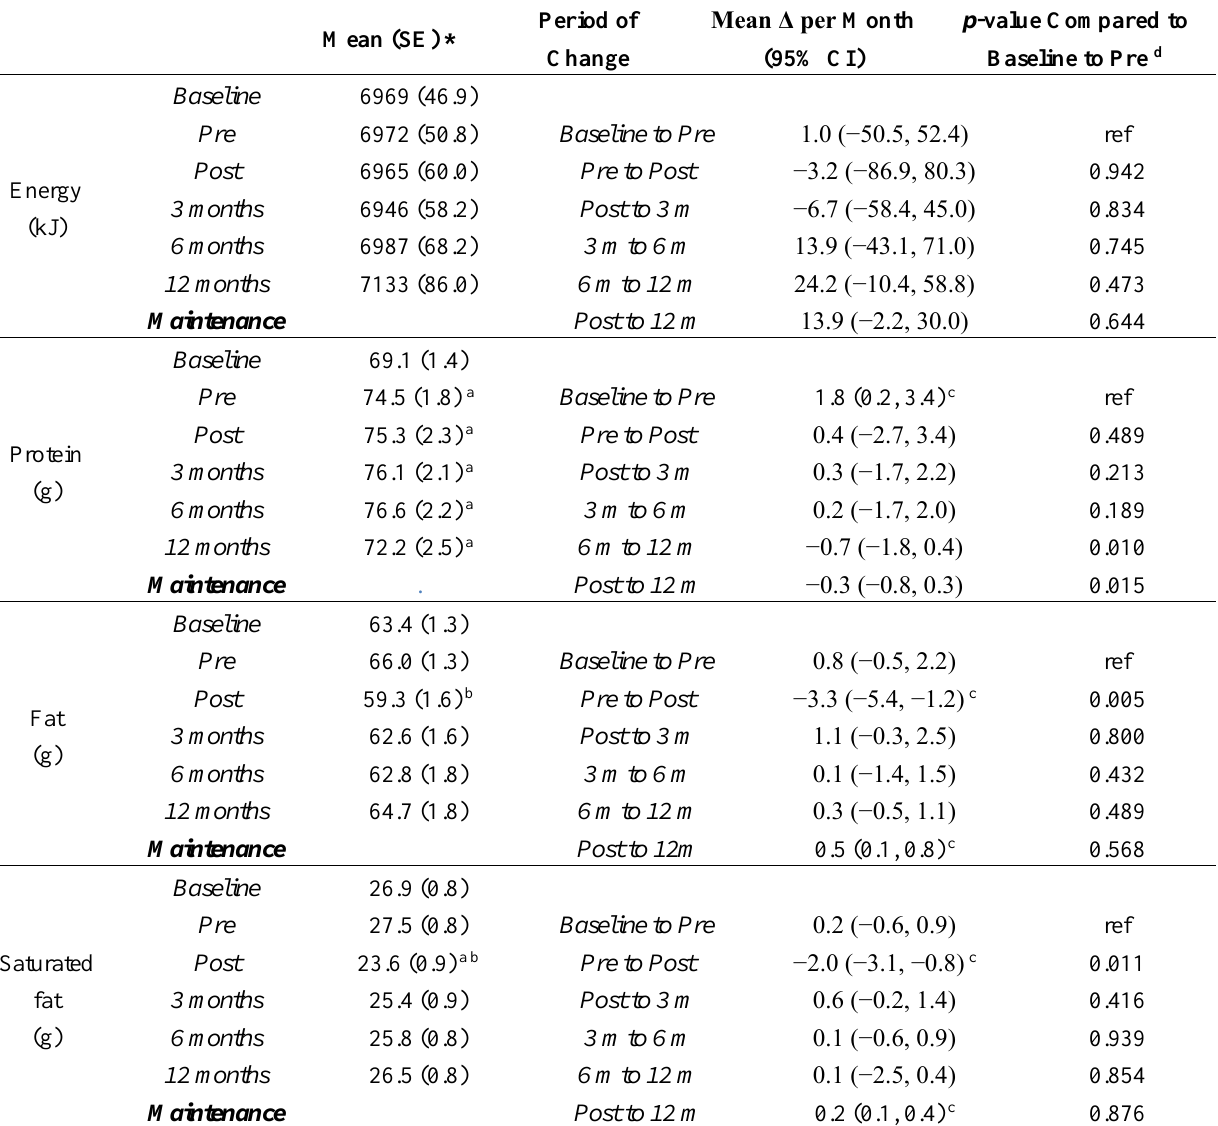
Table 2. Mean nutrient intake (point estimates) and rates of change across intervention and follow up in a cohort of 58 overweight